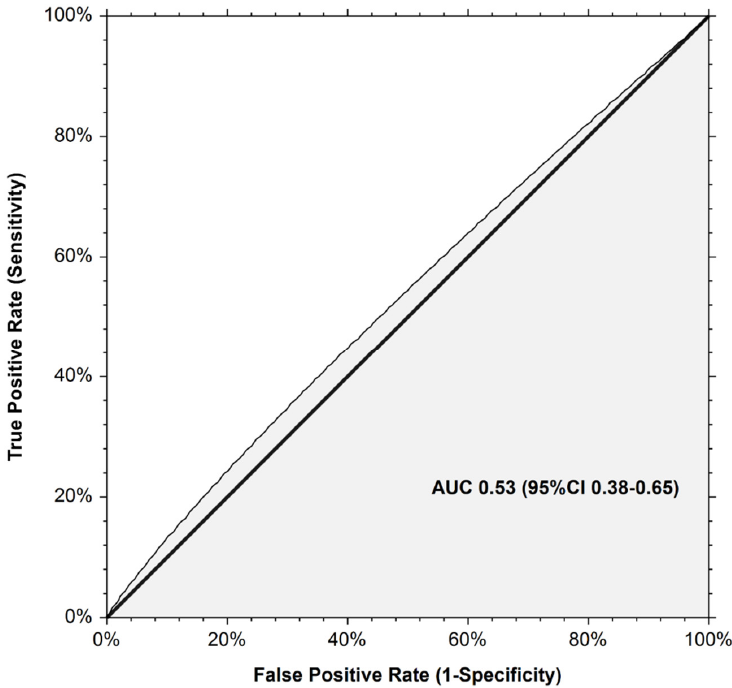
Figure 2. Receiver operating curve for the Ottawa score for prediction of recurrent venous throm- boembolism in the TROPIQUE cohort. Table 2. Multivariable analyses for recurrent VTE during the 6-month